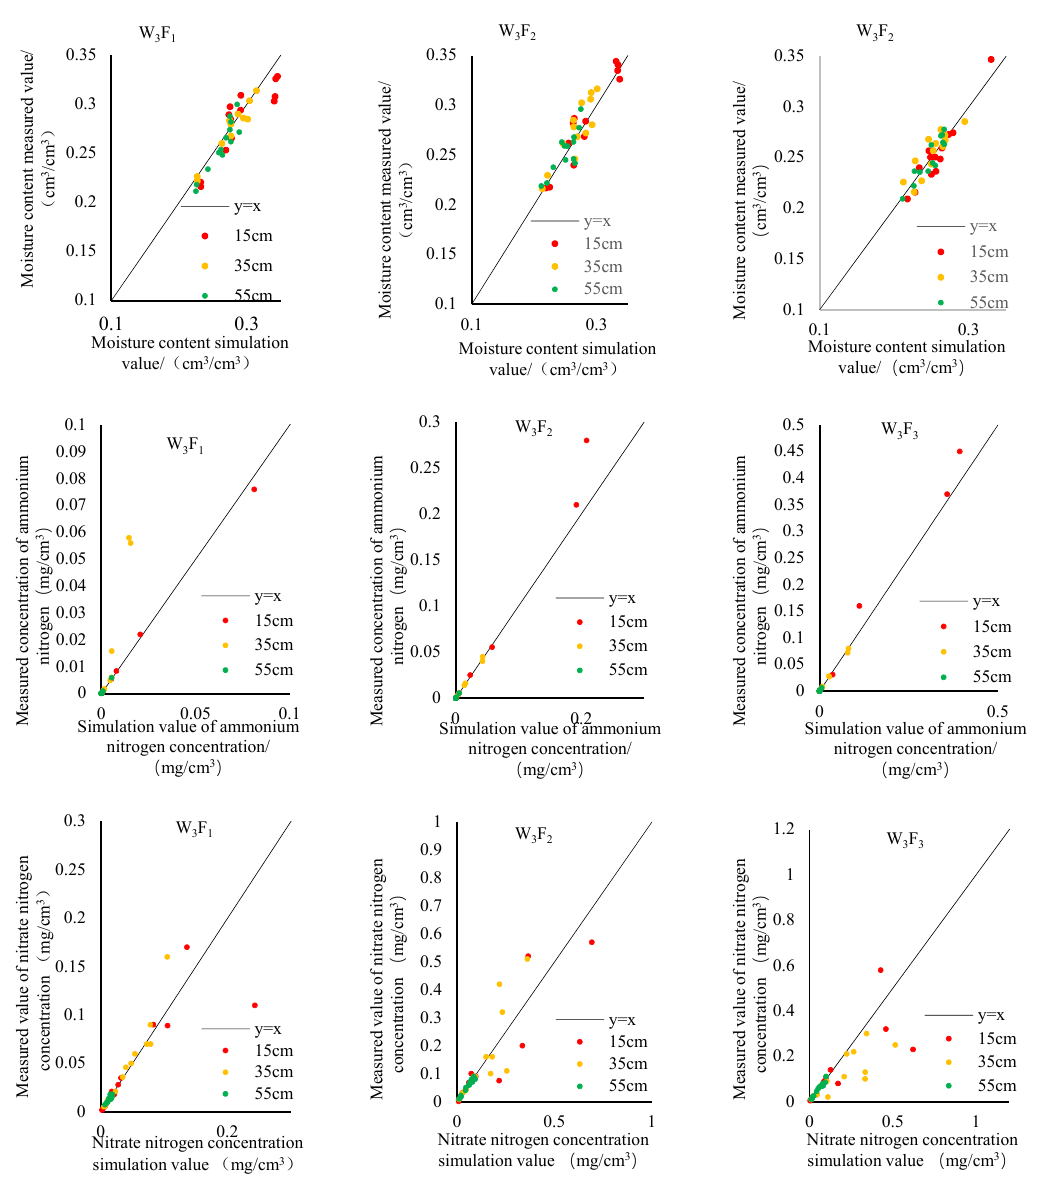
Figure 4. Comparison between simulated and measured values of vertical water content, ammo- nium nitrogen, and nitrate nitrogen in 2022.